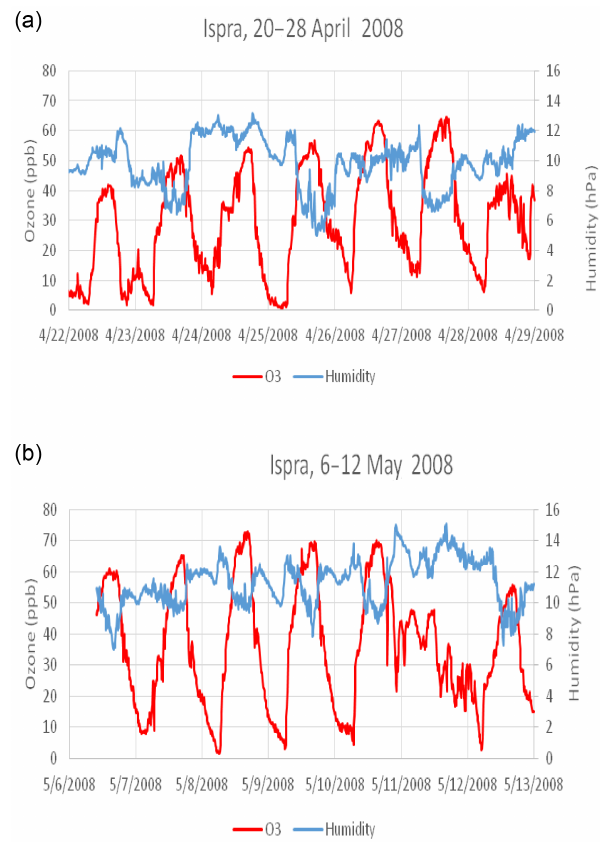
Figure 13. (a) Ozone-mixing ratio (red; ppb) and absolute humidity (blue; hPa) measurements at the JRC-Ispra station during the 26– 27 April 2008 ozone episode. (b) Ozone-mixing ratio (red; ppb) and absolute humidity (blue; hPa) measurements at the JRC-Ispra station during the 7–9 May 2008 ozone